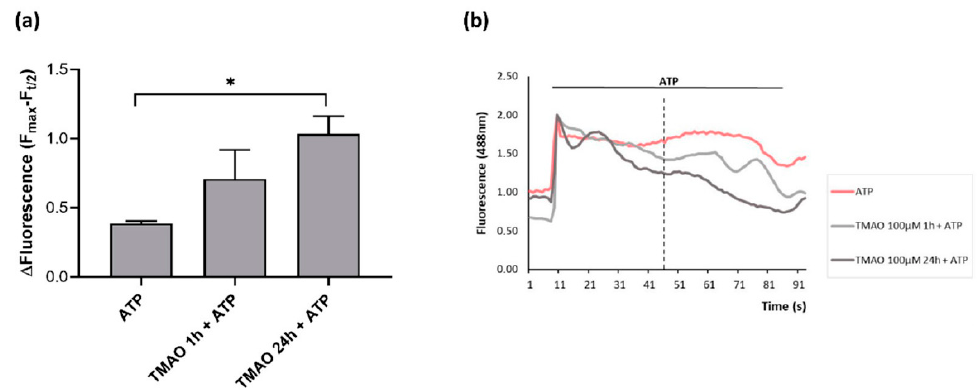
Figure 4. TMAO treatment alters intracellular calcium in purinergic response to ATP. ( a ) Bar graph representing the F max -F t/2 fluorescence after ATP stimulation in basal condition (ATP) or after treatment with TMAO 100 µ M for 1 h or 24 h. Number of cells for each experimental condition: ATP: 47; TMAO 1 h + ATP: 47; TMAO 24 h + ATP: 47 (n = 4 independent experiments). * p < 0.05 ( b ) Mean fluorescence variations of normalized curves aligned with respect to the peak value (F max ) after ATP stimulation in a single representative experiment. Dotted line indicates the t/2 at which curve differences were considered.